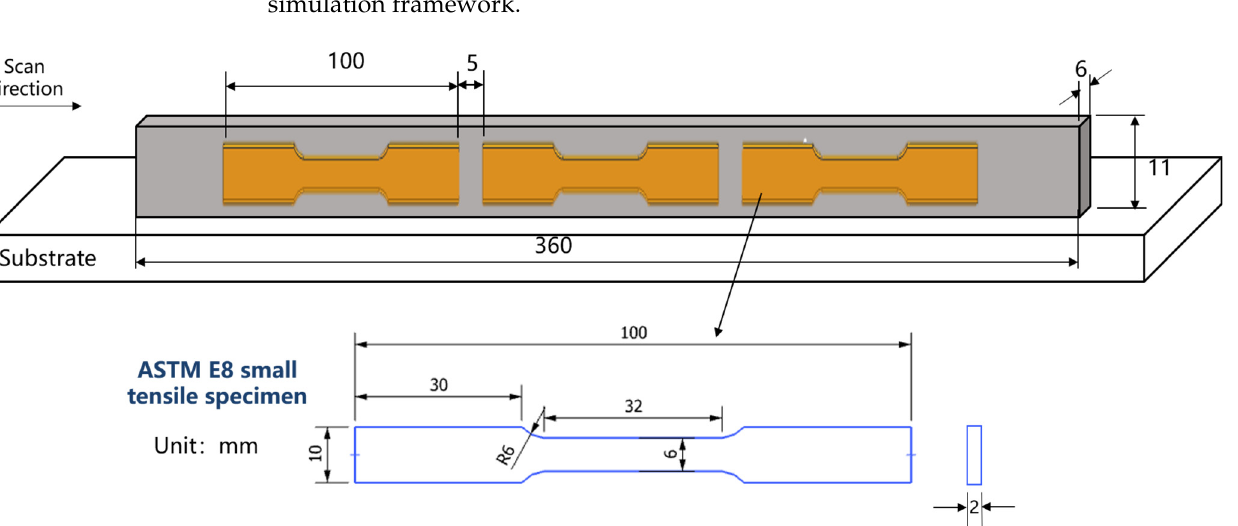
20 Figure 16. The 4 ‐ layer microstructure by the CA simulation. Table 4. The experiment and simulation comparison of the four ‐ layer microstructures.